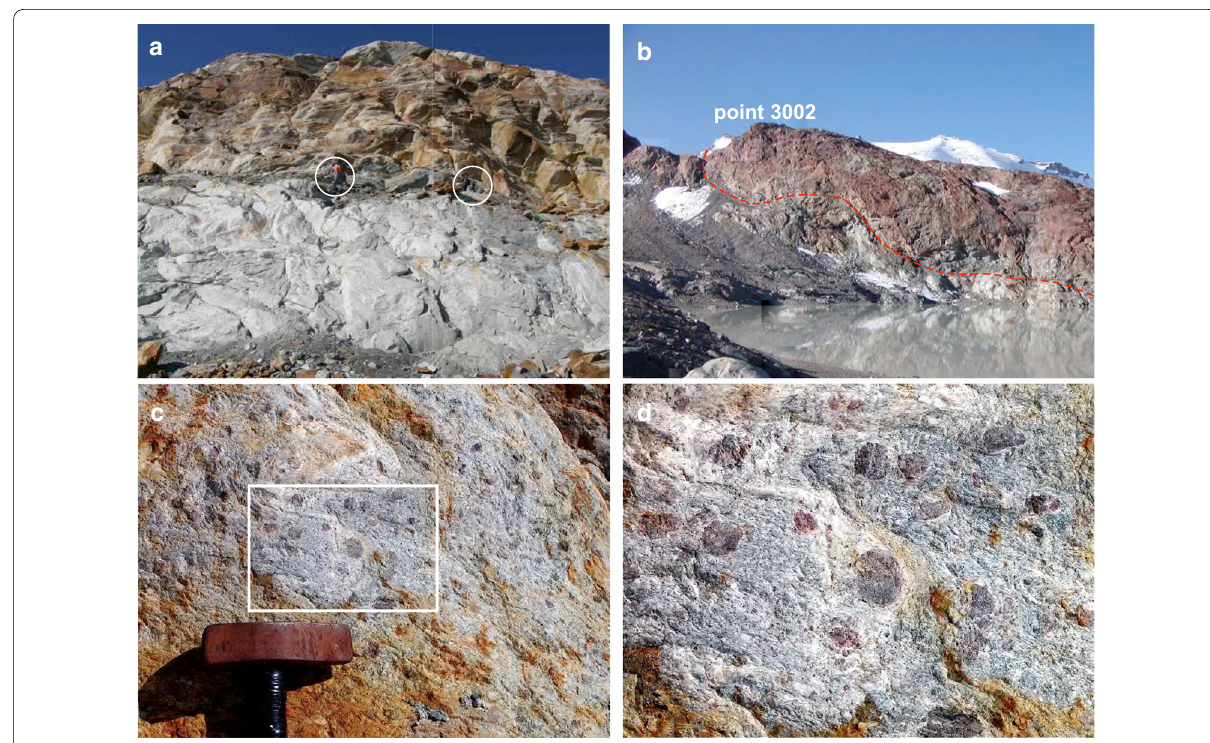
Fig. 4 a NE-face of point 3030. Low ground: Light-gray foliated meta-gabbro of the ZSU with well-preserved omphacite. Top part of wall: Rusty-weathering Grt-Ph schists (sampling site of KB860 and OK-Z133) and Bt-gneiss (Fig. 3). The basal thrust of the Theodul Glacier Unit in the middle of the wall and is well marked with small serpentinite lenses (e.g. at the position of the two geologists in white circles). b Point 3002 seen from north (Figs. 2 and 3). Basal thrust of TGU marked with red dashed line (ZSU above the lake, TGU at the top). Along the thrust several small serpentinite lenses occur. Rusty TGU rocks are predominantly Grt-mica-schists. Eclogites and Bt-gneiss are greyish colored. c Garnet-phengite schist at outcrop scale. Note cm sized and euhedral undeformed garnet (hammer head is 12 cm). d Close-up of framed area on